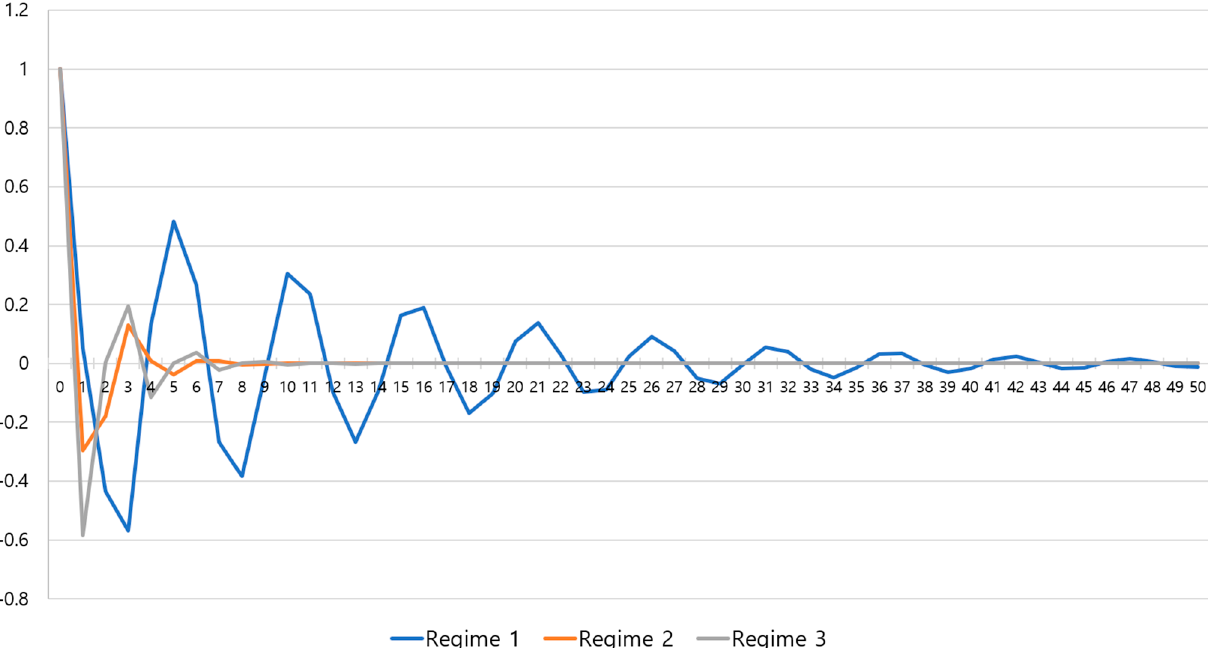
Figure 3. Estimation of the impact response periods of retail pork prices according to the regime for the African Swine Fever (ASF)-related news frequency. The x axis indicates the period (day) and the y axis indicates the retail price responded to impulse.